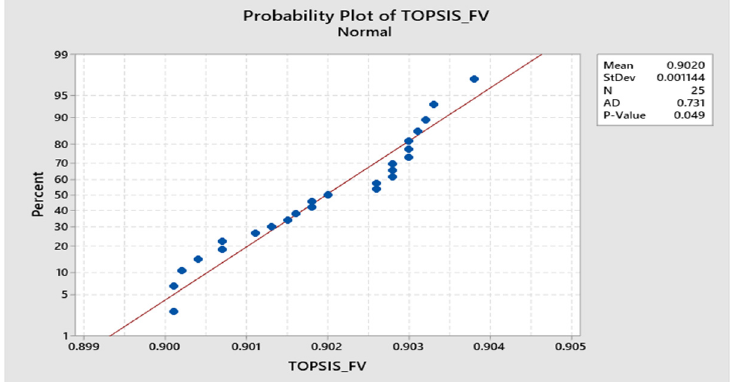
Figure 9. Normality test of 25 runs.